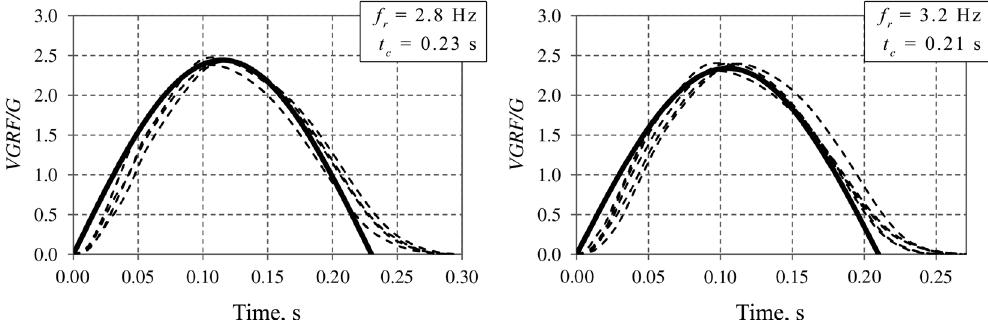
Figure 9. The normalised VGRF / G determined for f r = 2.8 Hz and f r = 3.2 Hz using Eq. (2) using adjusted t c,f values (input parameters presented in the